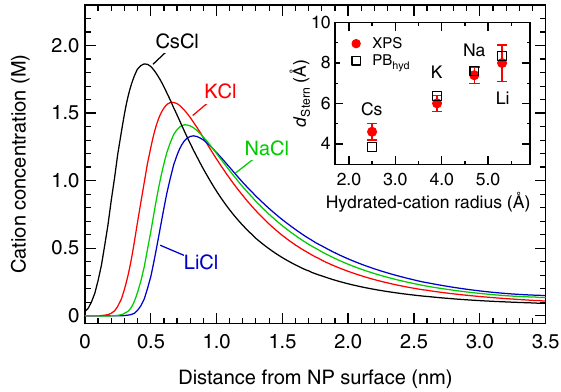
FIG. 7. Counterion concentration profiles in the electrical double layer. Cation concentration profiles as predicted by the hydration-modified PB model (solid lines) for 50-mM electro- lyte: black, CsCl; red, KCl; green, NaCl; blue LiCl. Inset: Stern layer thicknesses calculated from experiments (red, closed symbols) and predicted by the hydration-modified PB model (black, open